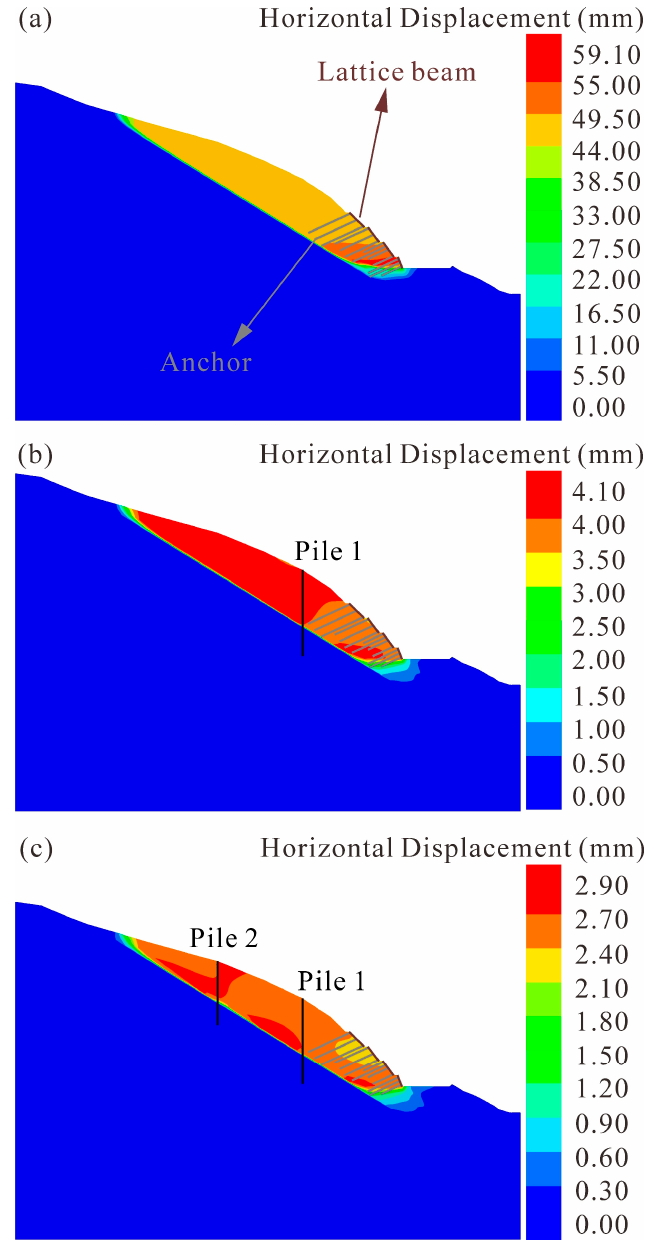
Figure 10. Numerical simulation of different protection strategies for the landslide. ( a ) Original protection strategy. ( b ) One row of piles in the middle of the landslide. ( c ) Two rows of piles in the middle and upper parts of the landslide respectively.